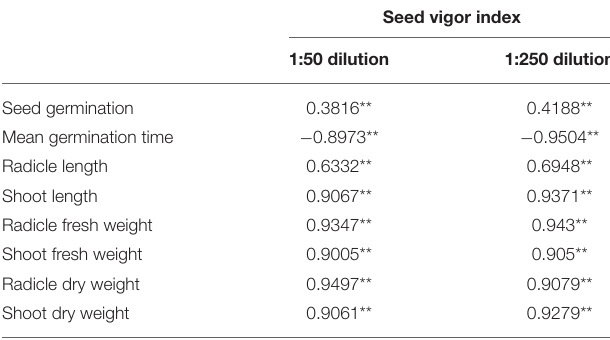
TABLE 2 | The correlation coefficient of laboratory traits and seed vigor index of